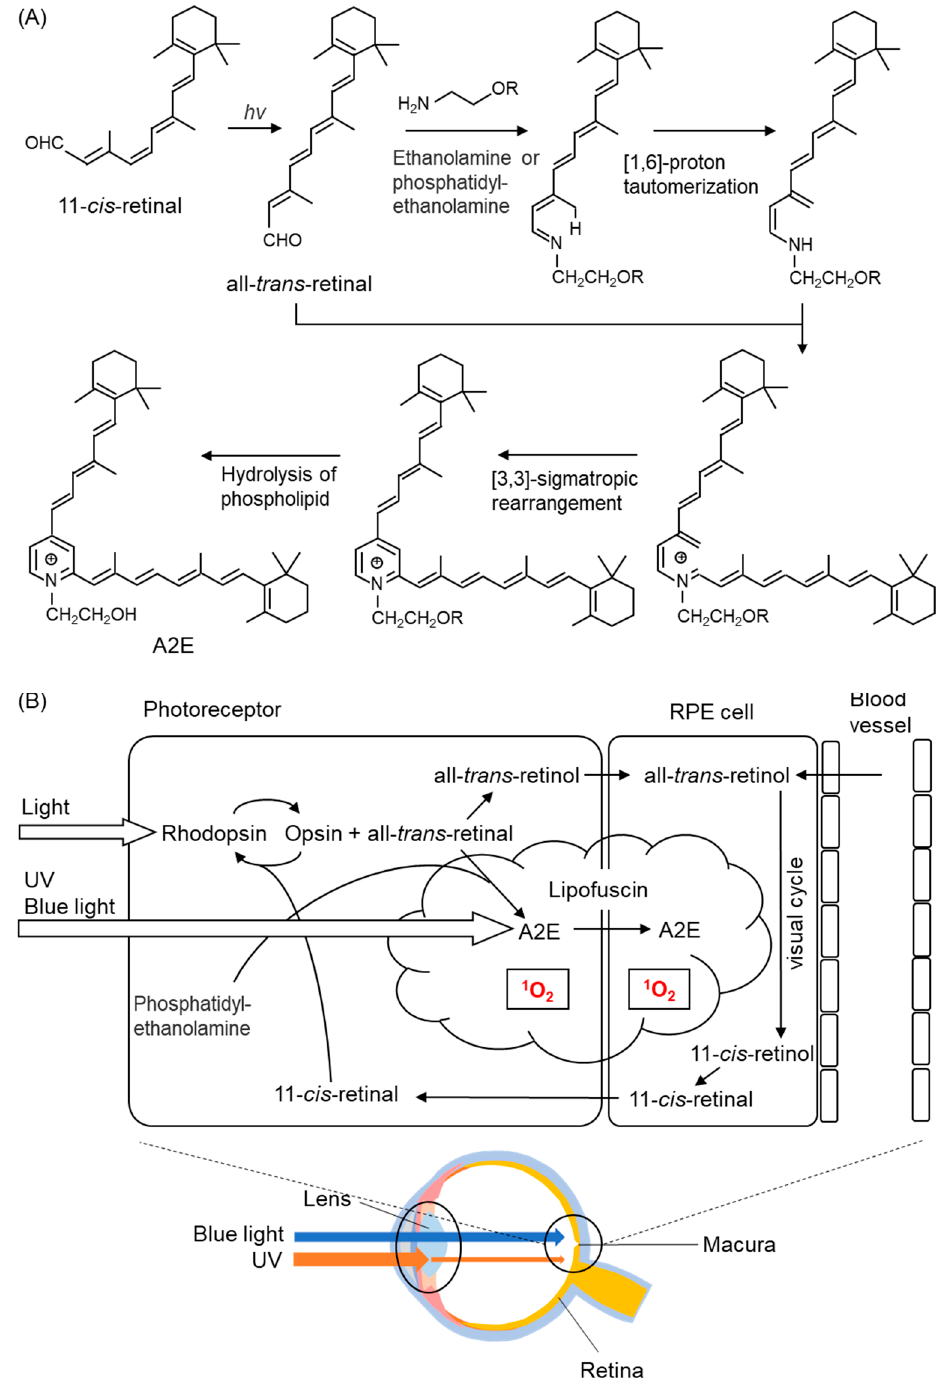
Figure 10. The structures of biosynthesis of A2E. ( A ) After Schiff base formation between all- trans - retinal and ethanolamine or phosphatidylethanolamine, a [1,6]-proton tautomerization to enamine follows. After further Schiff base formation with a second molecule of all- trans- retinal, a [3,3]-sigmatropic rearrangement is followed by the hydrolysis of the linked phosphatidylethanolamine adduct, resulting in the formation of N-retinyl-N-retinylidene ethanolamine (A2E). ( B ) 1 O 2 production process mediated by A2E in the retina. Light irradiation of A2E accumulated in lipofuscin generates 1 O 2 . ROS and radicals generated by light act on the cell membrane lipids of photorecep- tors to form lipid radicals [195,196]. Recently, photo-oxidative stress has been found to